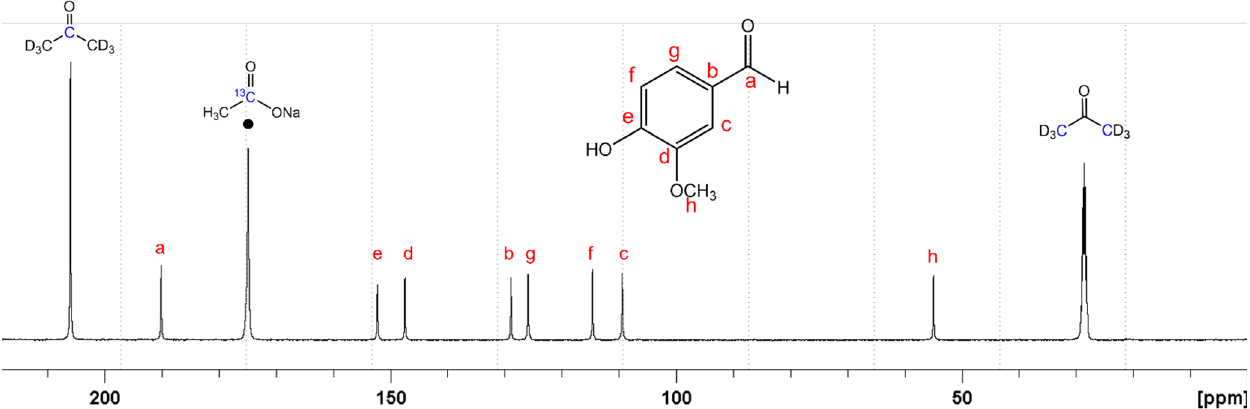
Figure 3. 13 C NMR (nuclear magnetic resonance) spectrum of a vanillin sample in acetone-d6, in the presence of CH 313 CO 2 Na ( ● ) as internal standard and Cr(acac) 3 as relaxation agent. Peaks of solvent, standard, and analyte were assigned.